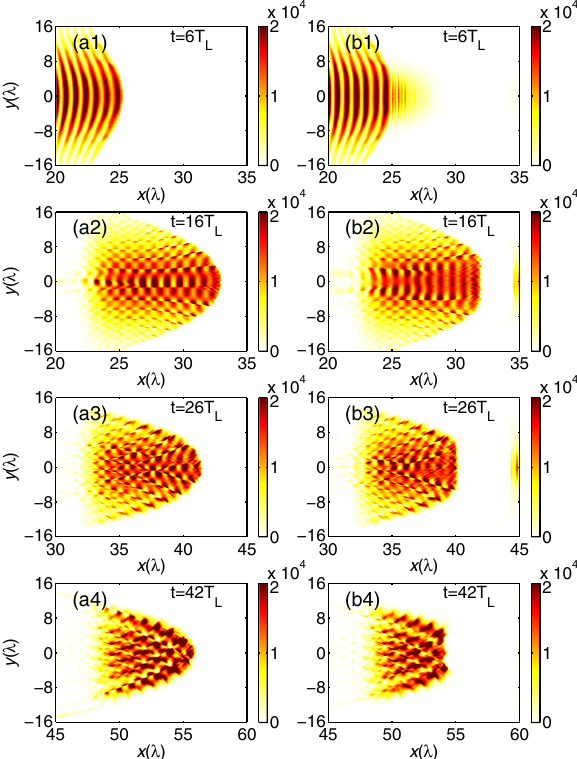
FIG. 3. The spatial density distributions (normalized by n c ) of the proton for the single laser case (a1) – (a4) and two lasers case (b1) – (b4). These snapshots are corresponding to four specific moments, t ¼ 6 T L , t ¼ 16 T L , t ¼ 26 T L , and t ¼ 42 T L .